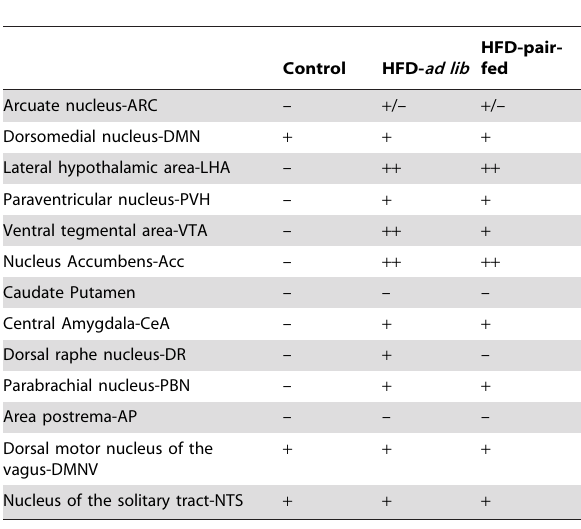
Table 1. Relative density of c-Fos-IR in the central nervous system of experimental groups 1